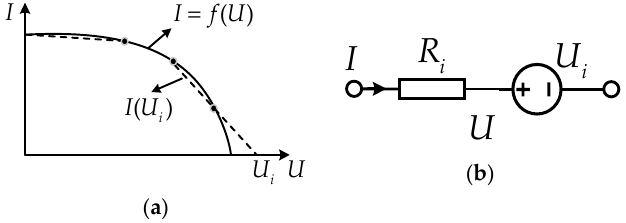
Figure 2. Piecewise linearization and equivalent circuit of the nonlinear source: ( a ) current-voltage ( I – U) curve and piecewise linearization; ( b ) equivalent circuit.